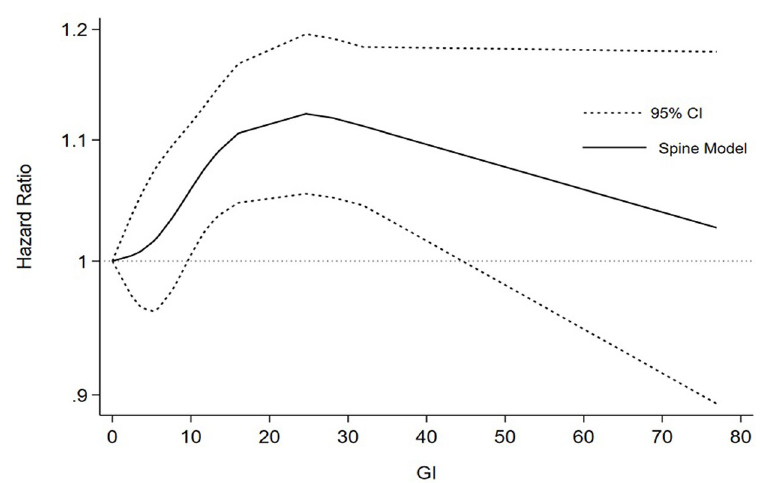
Fig 5. Dose-response association between GI and lung cancer.